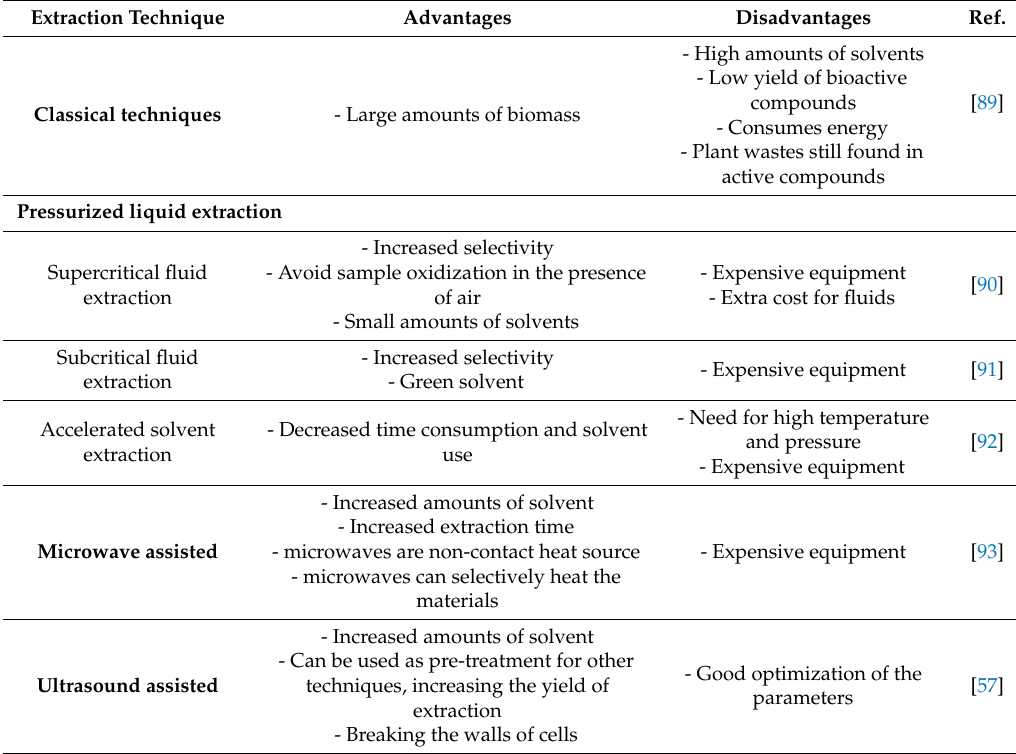
Table 2. Comparison of di ff erent conventional extraction